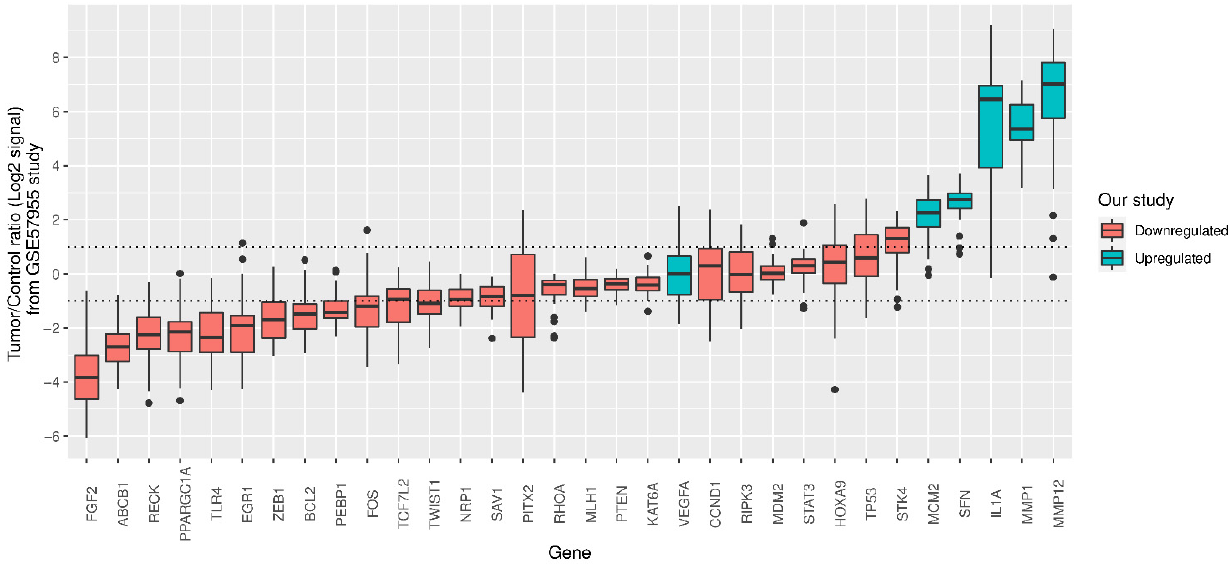
Figure 3. Gene expression ratios of log2 signal between penile cancer samples ( n = 39) and a pool of five autopsy glans (control group) from the GSE57955 dataset. Thirty-two (out of 37) differentially expressed genes (DEGs) detected in our study were available in this dataset. All median values above 1.0 or below − 1.0 were considered as di ff erentially expressed in the GSE57955 study. Box plots for each gene were colored according to its regulation type in our study (red for down- regulated genes and blue for upregulated genes). Five upregulated genes and ten downregulated genes from our study were confirmed in this dataset.